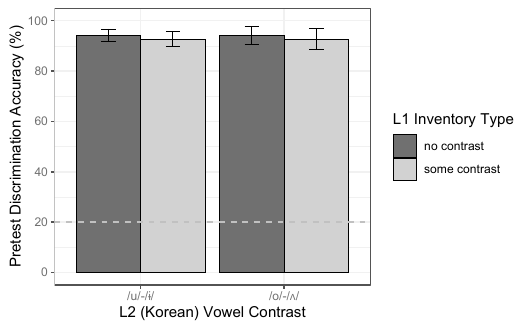
Figure 7. Pretest performance in the vowel study (accuracy in oddball discrimination), by L2 vowel contrast and L1 group (i.e., vowel inventory type). Error bars indicate SE of the mean over participants; the dotted line marks chance ‐ level performance (20%).